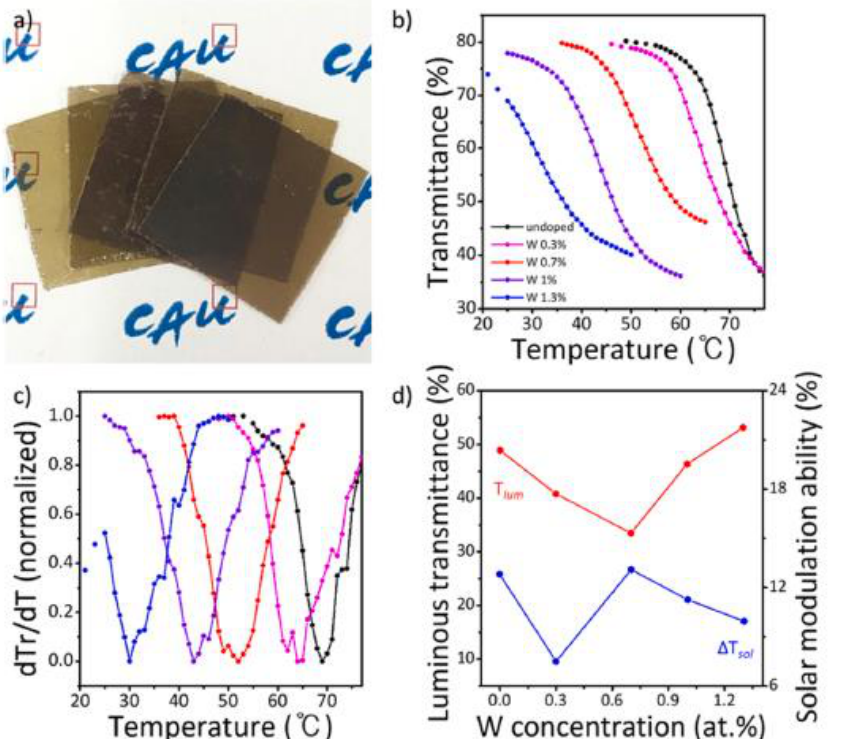
Figure 8. ( a ) Photograph of VO 2 (M) thin films on PET substrates for various W doping concentrations; ( b ) Temperature dependence of transmittance; ( c ) First derivatives of transmittance; ( d ) Luminous transmittance (T lum ) and solar modulation ability ( ∆ T sol ) of VO 2 (M)/mica thin films under various W doping concentrations (1900 nm). Reproduced with permission from [74]. Copyright 2021, Elsevier.